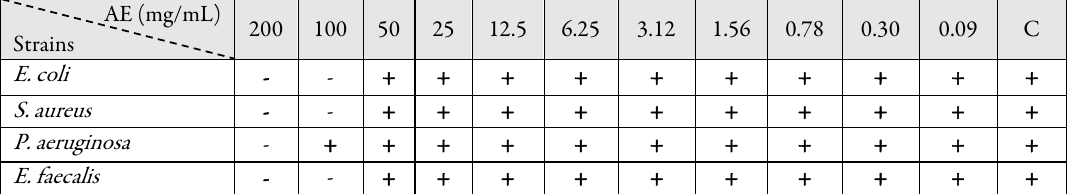
Table 5. MIC of the aqueous extract of L. angustifolia against the different microbial strains studied AE